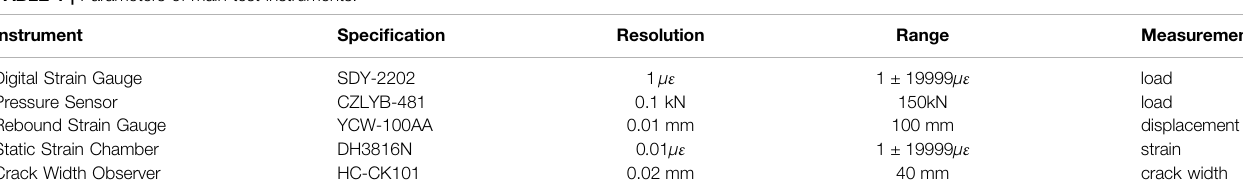
the rotating hinge are in the same vertical plane. According to the Saint-venant principle, the local load effect only in fl uences the stress fi eld distribution within a certain range (Bastin et al., 2021; TABLE 1 | Parameters of main test